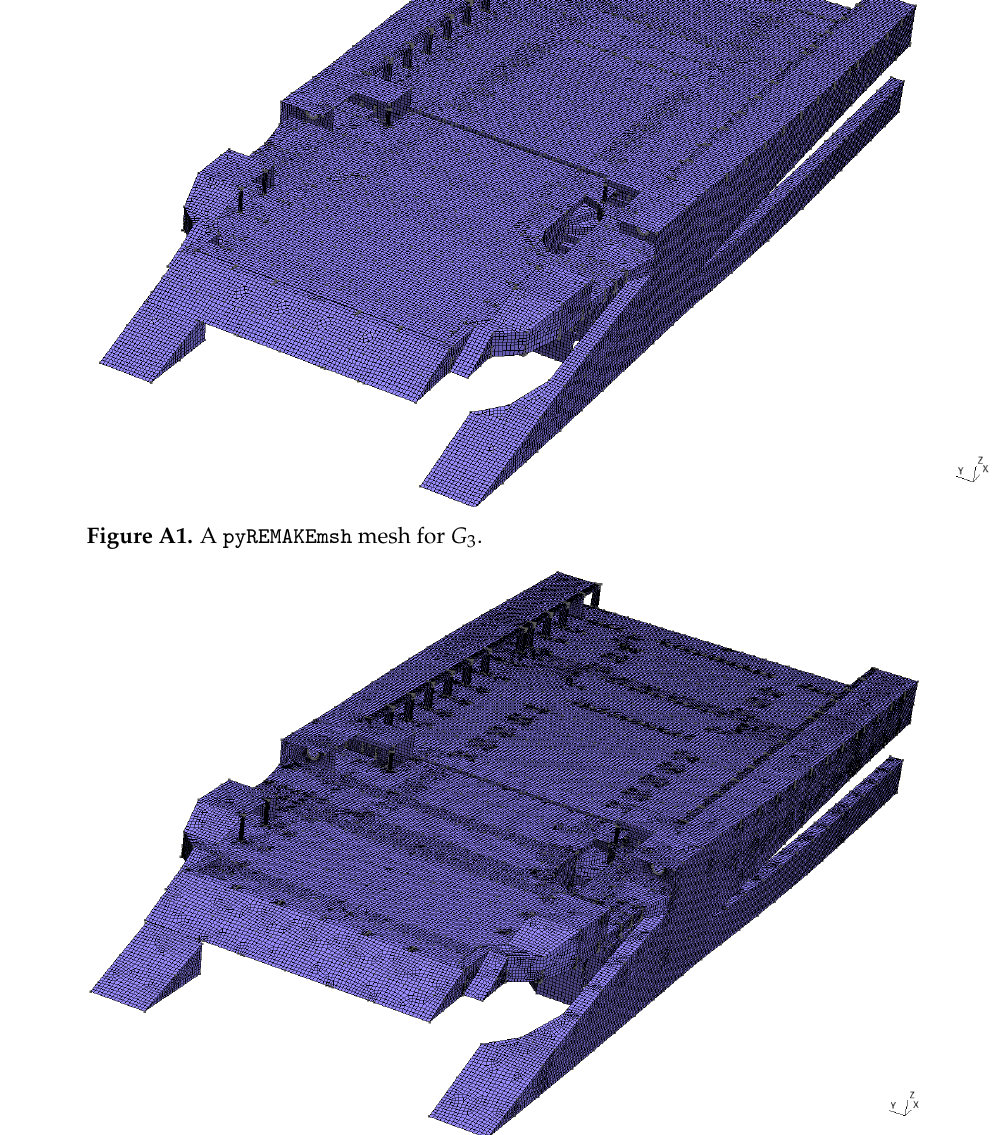
Figure A2. A full recombination mesh for G 3